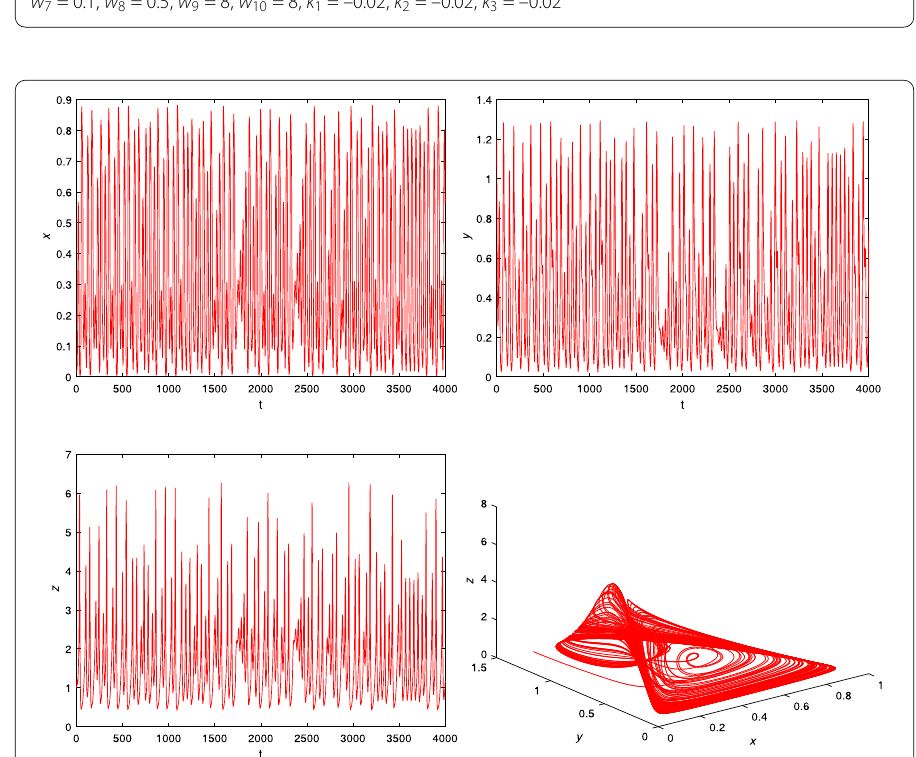
Figure 3 The trajectories and graphs of system (4.1) with τ = 4. The positive equilibrium E + still has a chaotic attractor